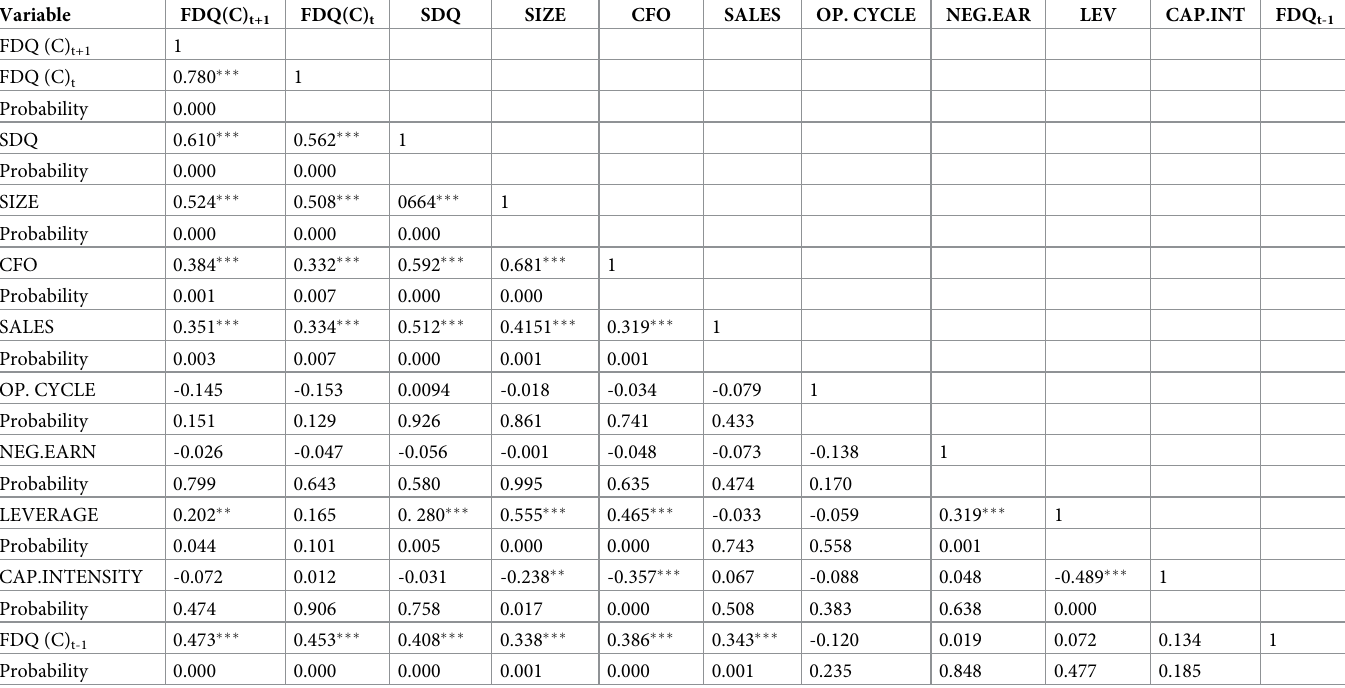
Table 6. Correlation matrix of the FDQ of Chen et al. [51].